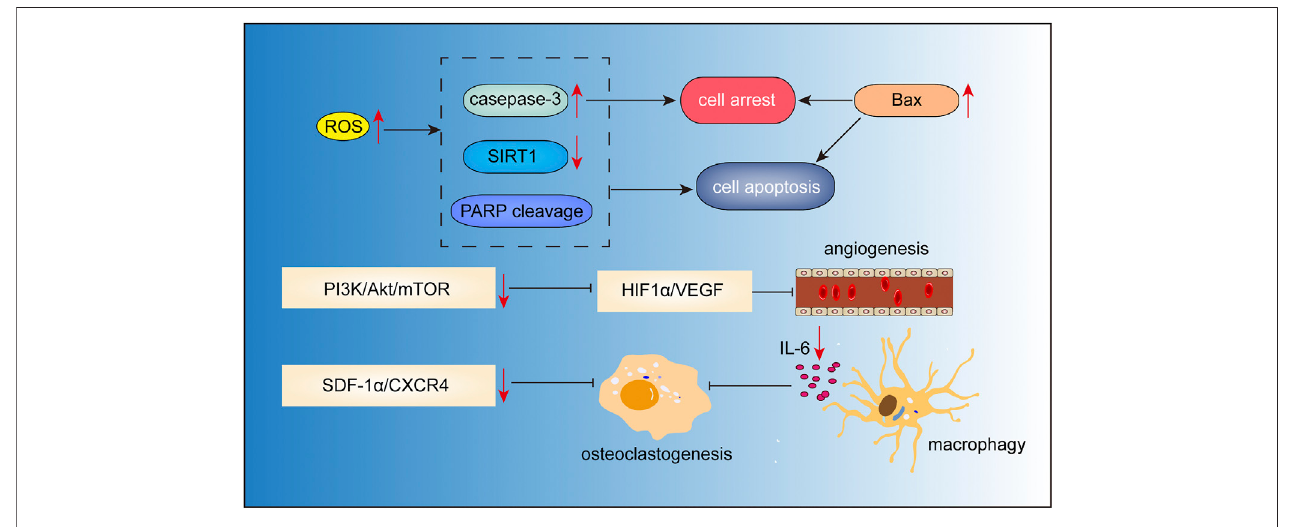
FIGURE 7 | Action pathways involved in the anti-MM effects of gambogic acid. represents inhibitory effects, represents stimulative